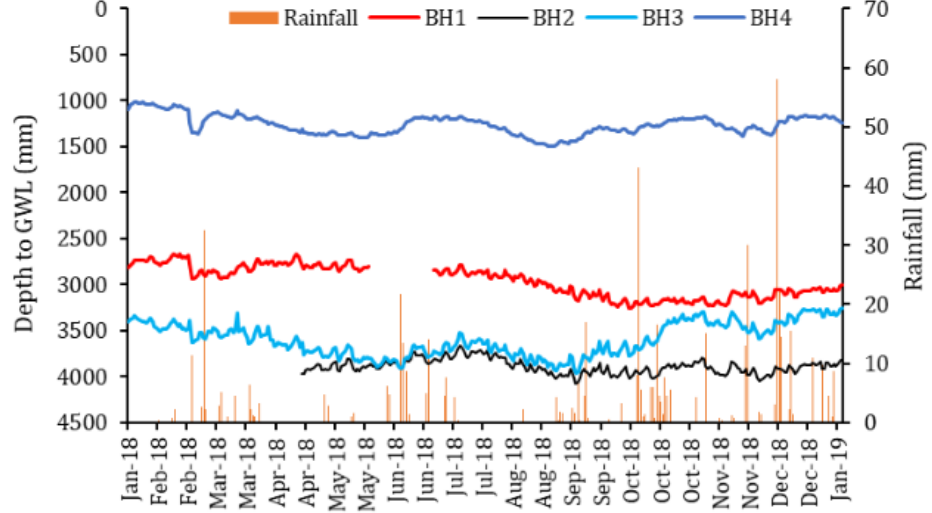
Figure 2. Daily rainfall and groundwater-level fluctuations for all the borewells over the monitoring Figure period.